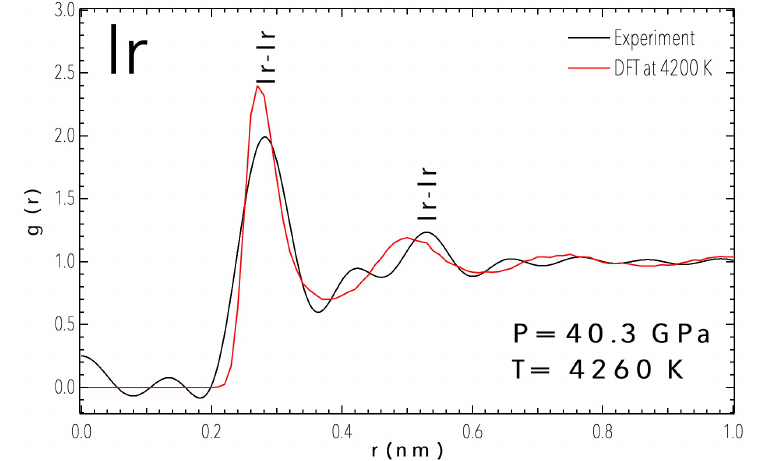
Figure 6. Comparison between the RDF signals of liquid Ir experimentally obtained at 40.3 GPa and 4260 K (black line) and the RDF signal obtained from DFT simulation at 4200 K and 40 GPa (red